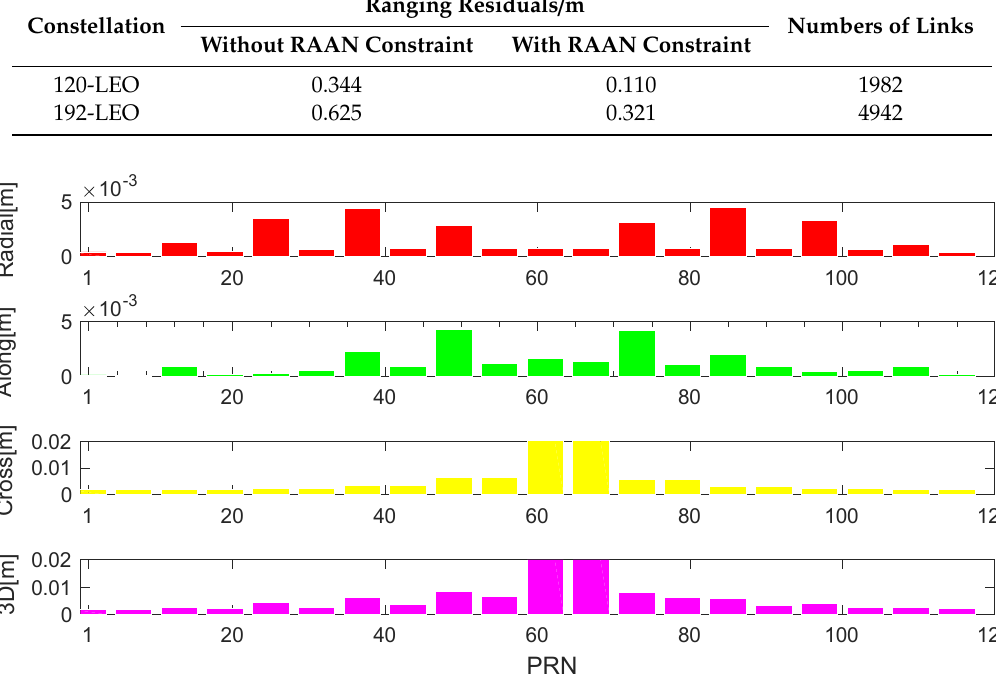
Figure 12. 192-LEO constellation orbital errors in radial, along-track, cross-track and 3D under 20 cm ranging accuracy, in which satellite of PRN 1, 10, 19…190 (divided at interval 9 of PRN number) are displayed. Table 5. Average orbital errors of 60- and 120-LEO constellations with references provided by navigation satellites. Constellation Orbital Errors / m